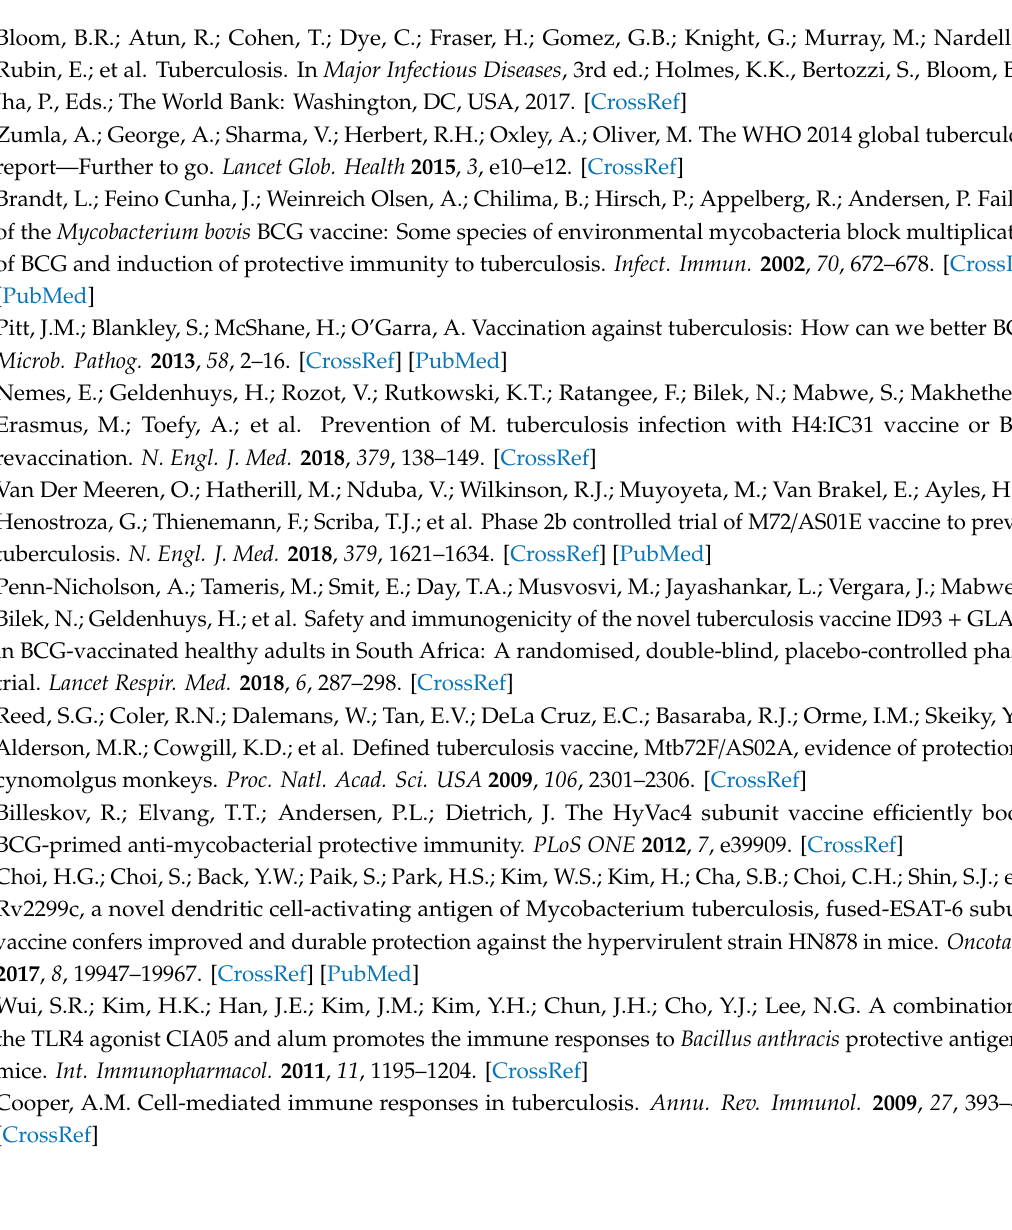
S10: IFN- γ / IL-17 from supernatants of lung and spleen cells from ESAT-6-vaccinated mice inhibit intracellular Mtb growth, Figure S11: IFN- γ / IL-17 from supernatants of lung cells from infected ESAT-6-vaccinated mice inhibit intracellular Mtb growth, Figure S12: IFN- γ / IL-17 from supernatants of spleen cells from infected ESAT-6-vaccinated mice inhibit intracellular Mtb growth, Figure S13: IFN- γ / IL-17 induces phagosome-lysosome fusion in Mtb-infected macrophages, Figure S14: IFN- γ / IL-17 does not a ff ect IFN- γ R1 in Mtb-infected macrophages, Figure S15: IFN- γ / IL-17 does not a ff ect ROS or NO production in Mtb-infected macrophages, Table S1: Correlations between protection level and vaccine-induced immune responses pre- and